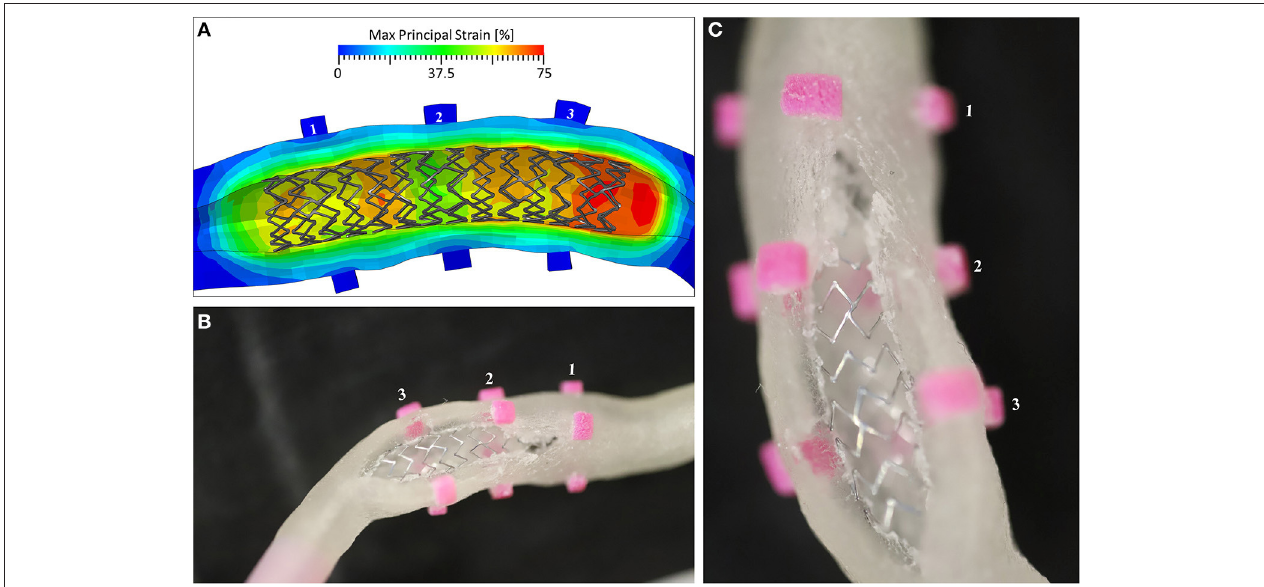
FIGURE 10 | (A) The Max Principal Strain plot at the end of the inflation phase, showing peaks of 75% deformation in the area of Marker 3; (B) the view of the broken mock vessel with (C) a detail of the exposed